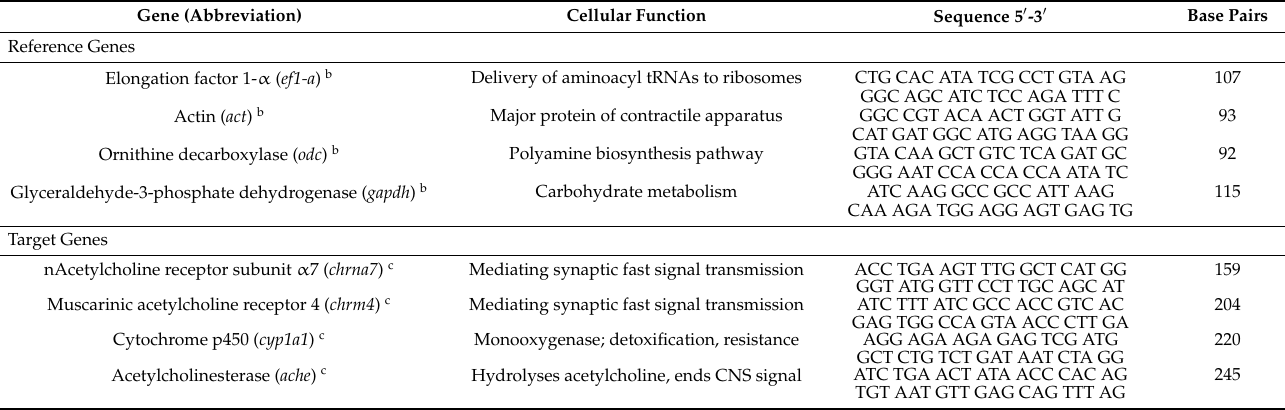
Table 2. Target and reference genes, their general cellular function, primer pair sequences a , and size in base pairs. Gene